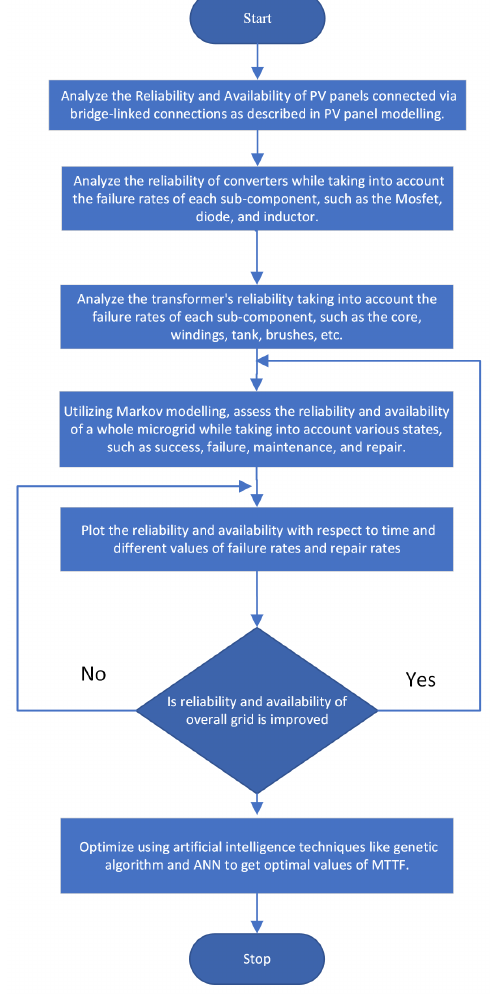
Figure 2. Flow chart of proposed